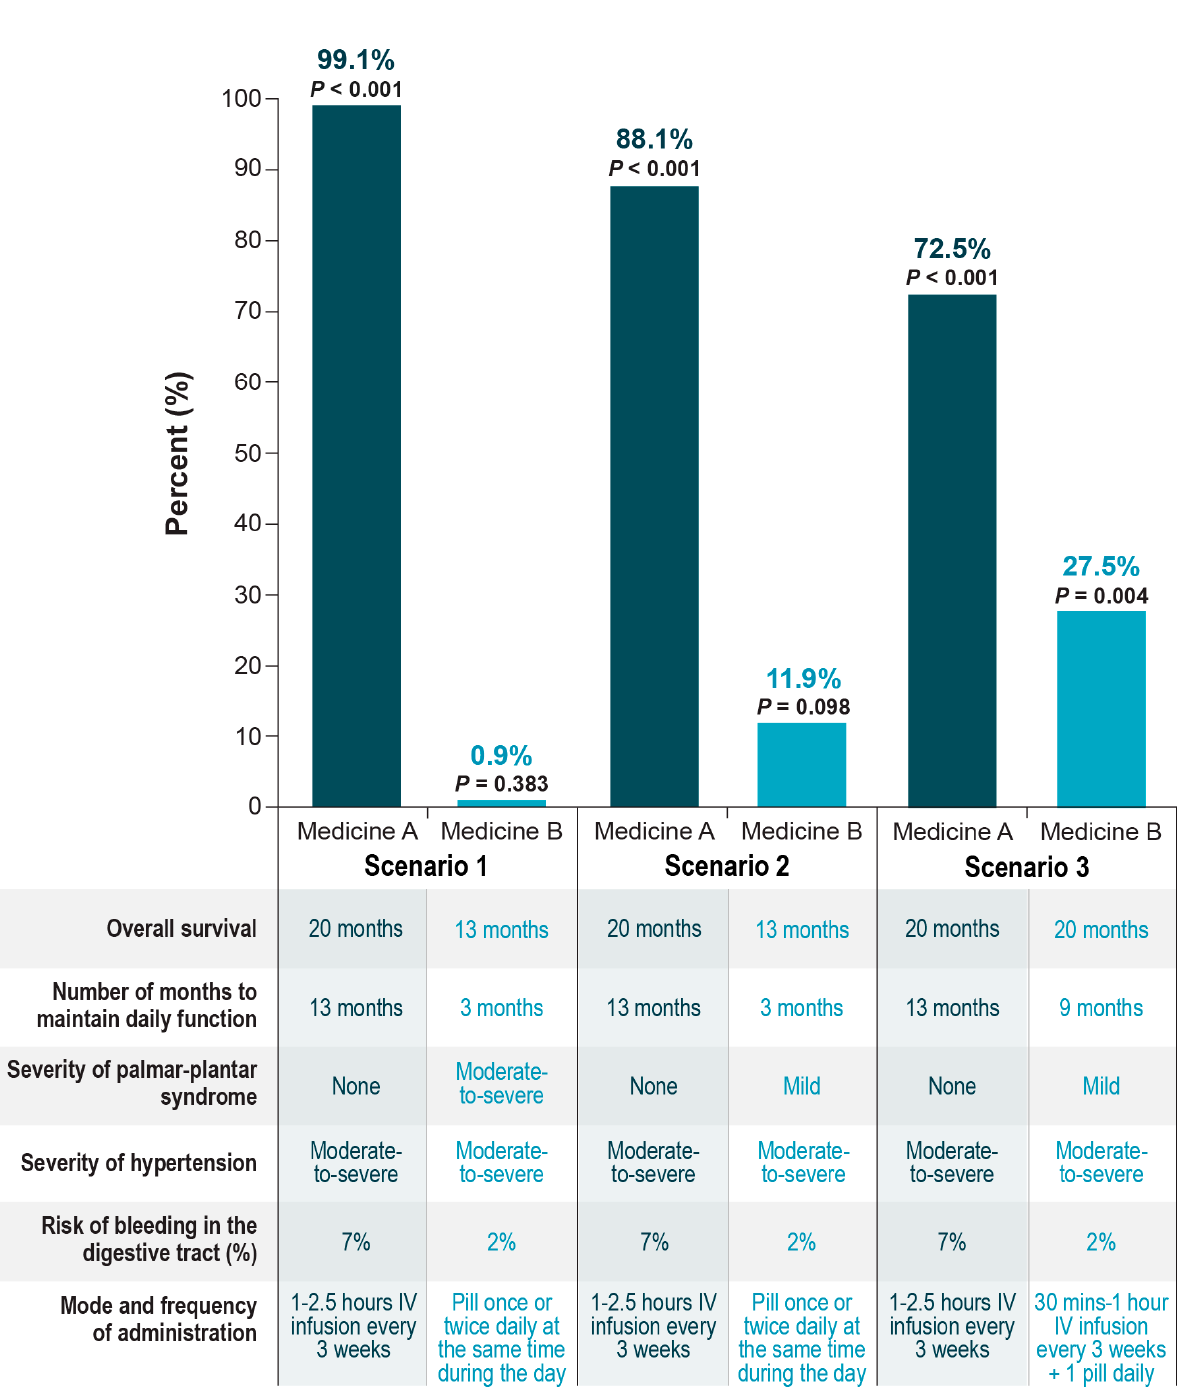
Figure 3. Respondent predicted choice probabilities. IV = intravenous.